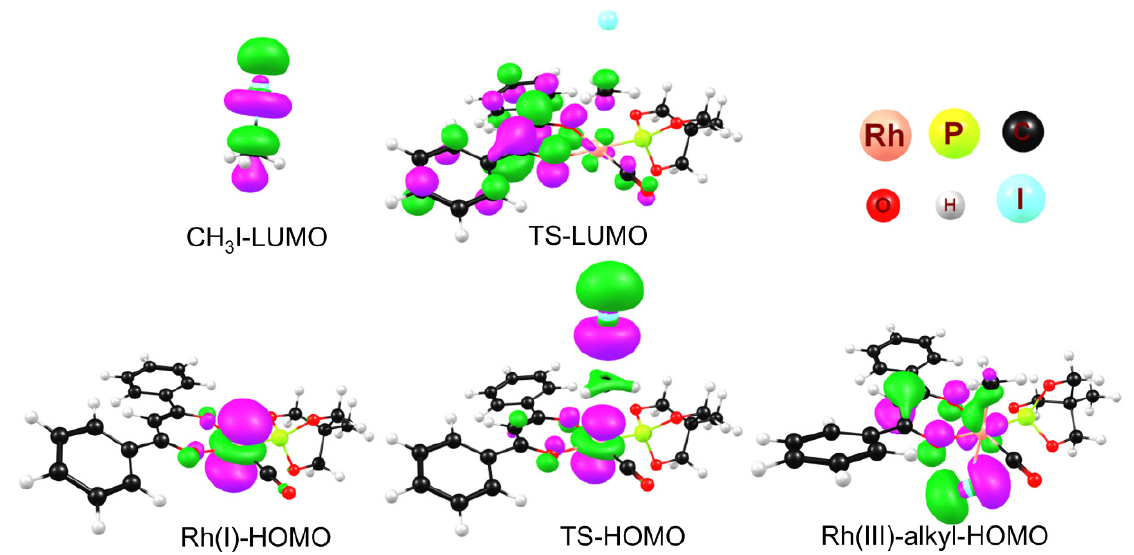
Figure 7. DFT optimized structure of the “linear/back” and “bent” transition states of the reaction [Rh(PhCOCHCOPh)(CO)(P(OCH + CH I. The Gibbs energies ( ∆ G ≠ ) of the transition states are 82 and 196 kJ mol -1 (0.85 and 2.03 eV) respectively, calculated in methanol 3 as solvent. The displacement vectors (green arrows) indicate the movement of the CH 3+ group at the negative frequency (-235.0 cm -1 with a calculated intensity of -481 for the linear TS and -319.0 cm -1 with a calculated intensity of -239 for the bent TS). Distances (Å, black) and colour code (online version) of the atoms are as indicated.